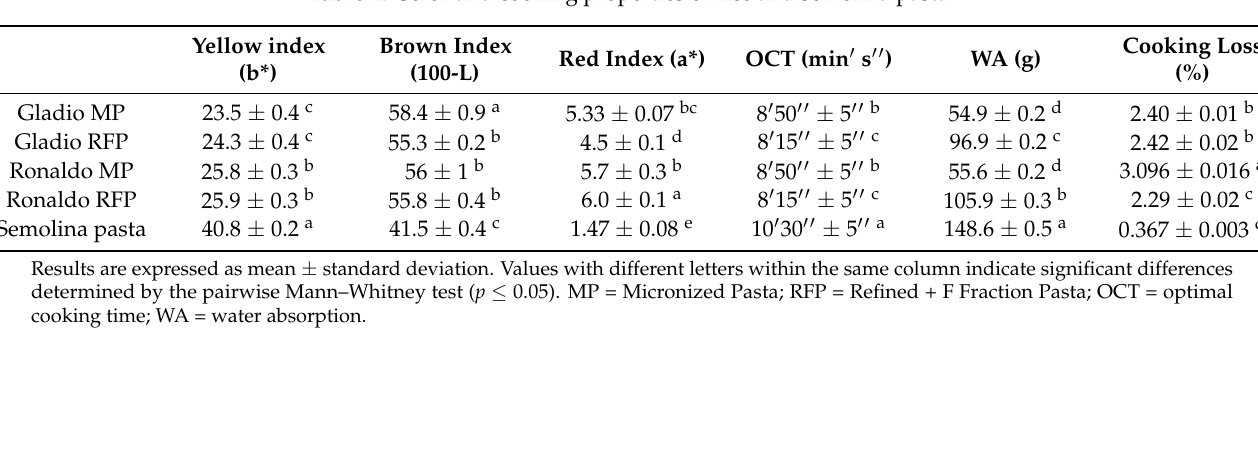
Table 2. Color and cooking properties of rice and semolina